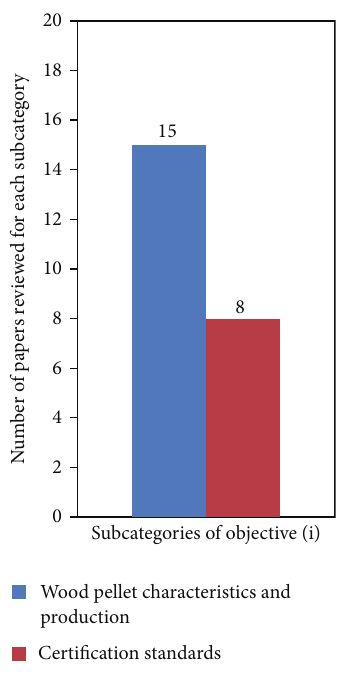
Figure 2: Publications reviewed for the subcategories of objective (i).